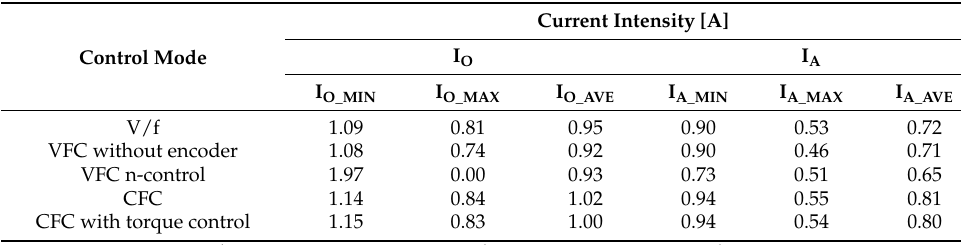
Table 12. Characteristics of the output current (I O ) and the active current (I A ) in a steady state (with the external load).